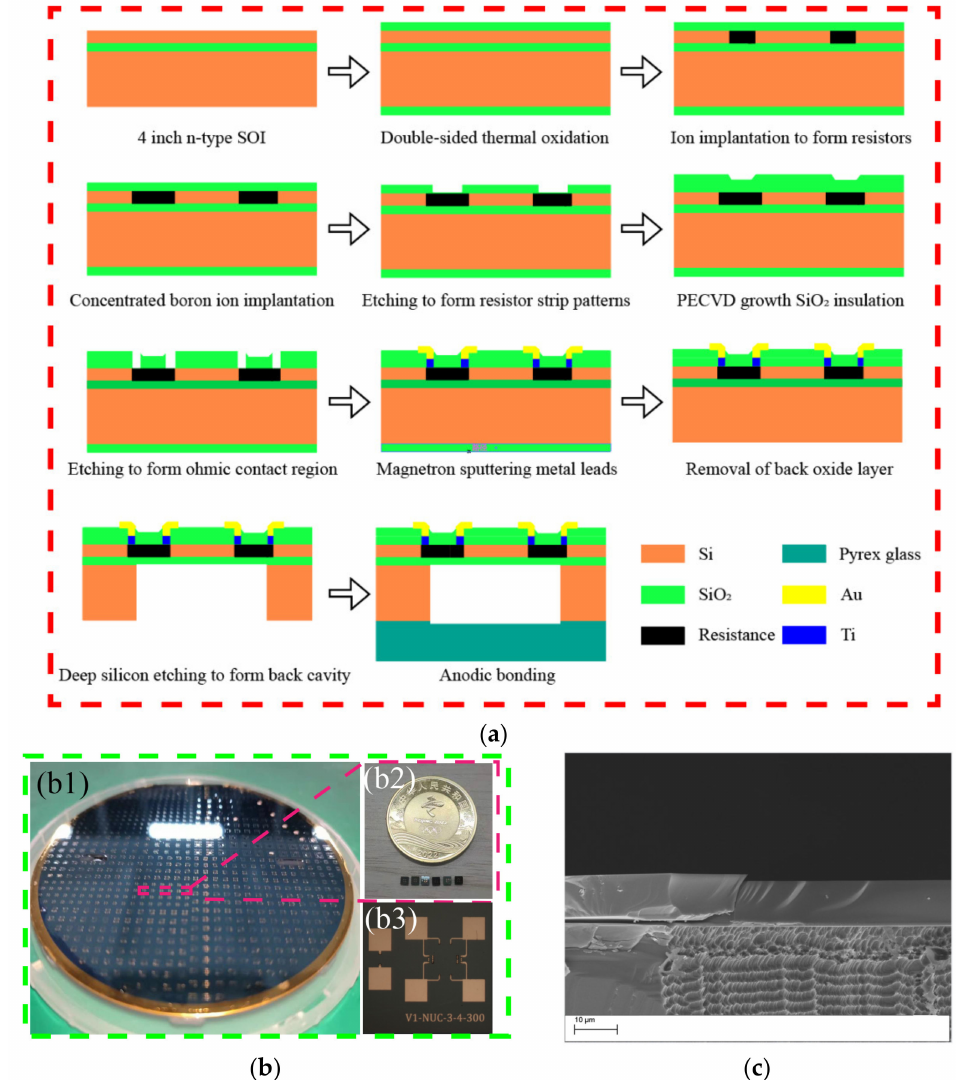
Figure 5. ( a ) Diagram illustrating chip manufacturing process; ( b1 ) diagram of fabricated sensor wafers; ( b2 ) diagram of several individual pressure sensor chips; ( b3 ) diagram of the top surface of the chip under the microscope; ( c ) diagram of cross-section of chip under SEM (scanning electron